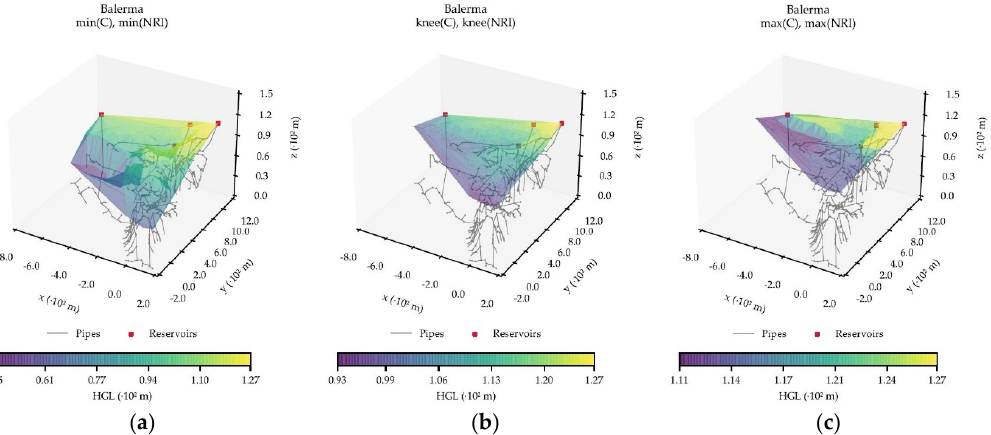
Figure 5. Balerma WDS with the corresponding HGL surfaces for the: ( a ) [min(C), min(NRI)]; ( b ) [knee(C), knee(NRI)]; and ( c ) [max(C), max(NRI)] configurations.